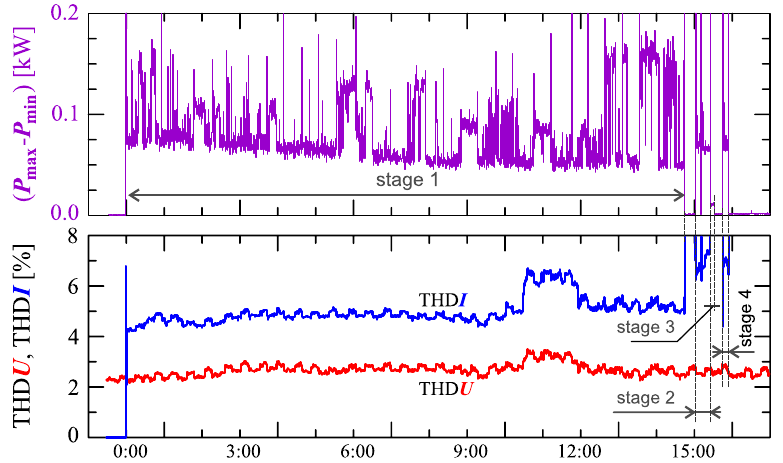
Figure 31. The characteristic of difference between the maximum and minimum active power ( P max − P ) = f ( t ) (top), and the characteristic of the voltage THD factor THD U = f ( t ) and current min THD factor THD I = f ( t ) (bottom) for Case IV.